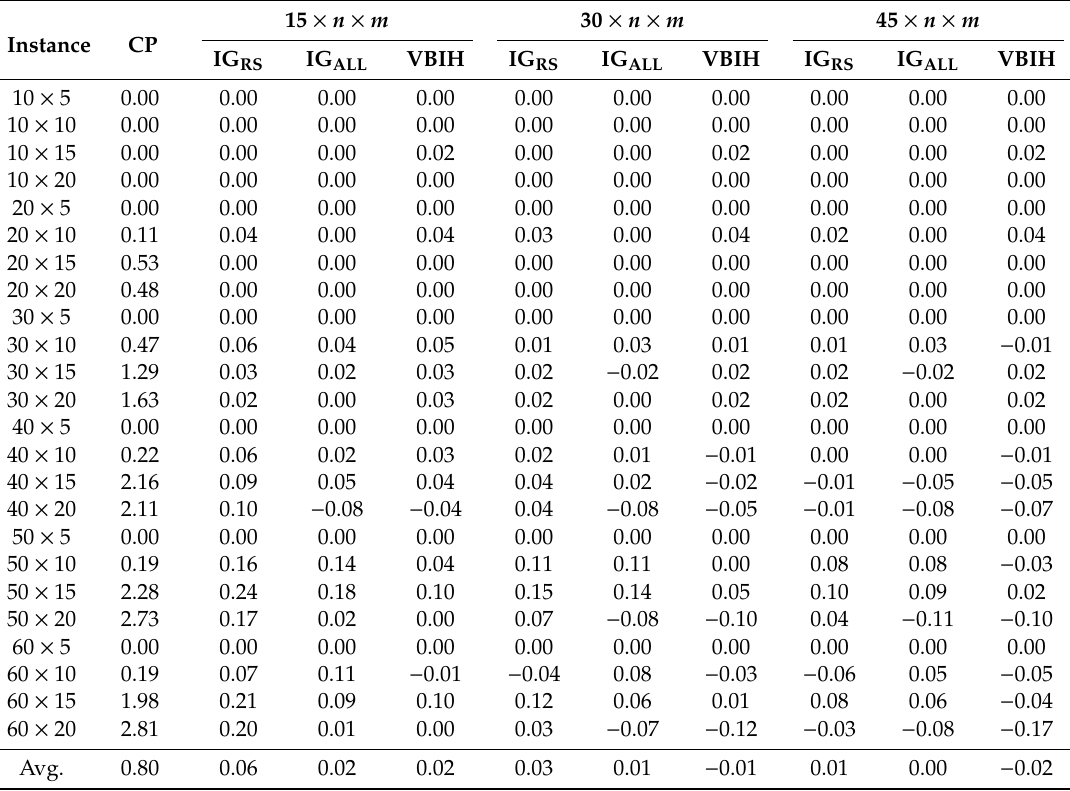
Table 4. Comparison of ARPD of all algorithms for small VRF